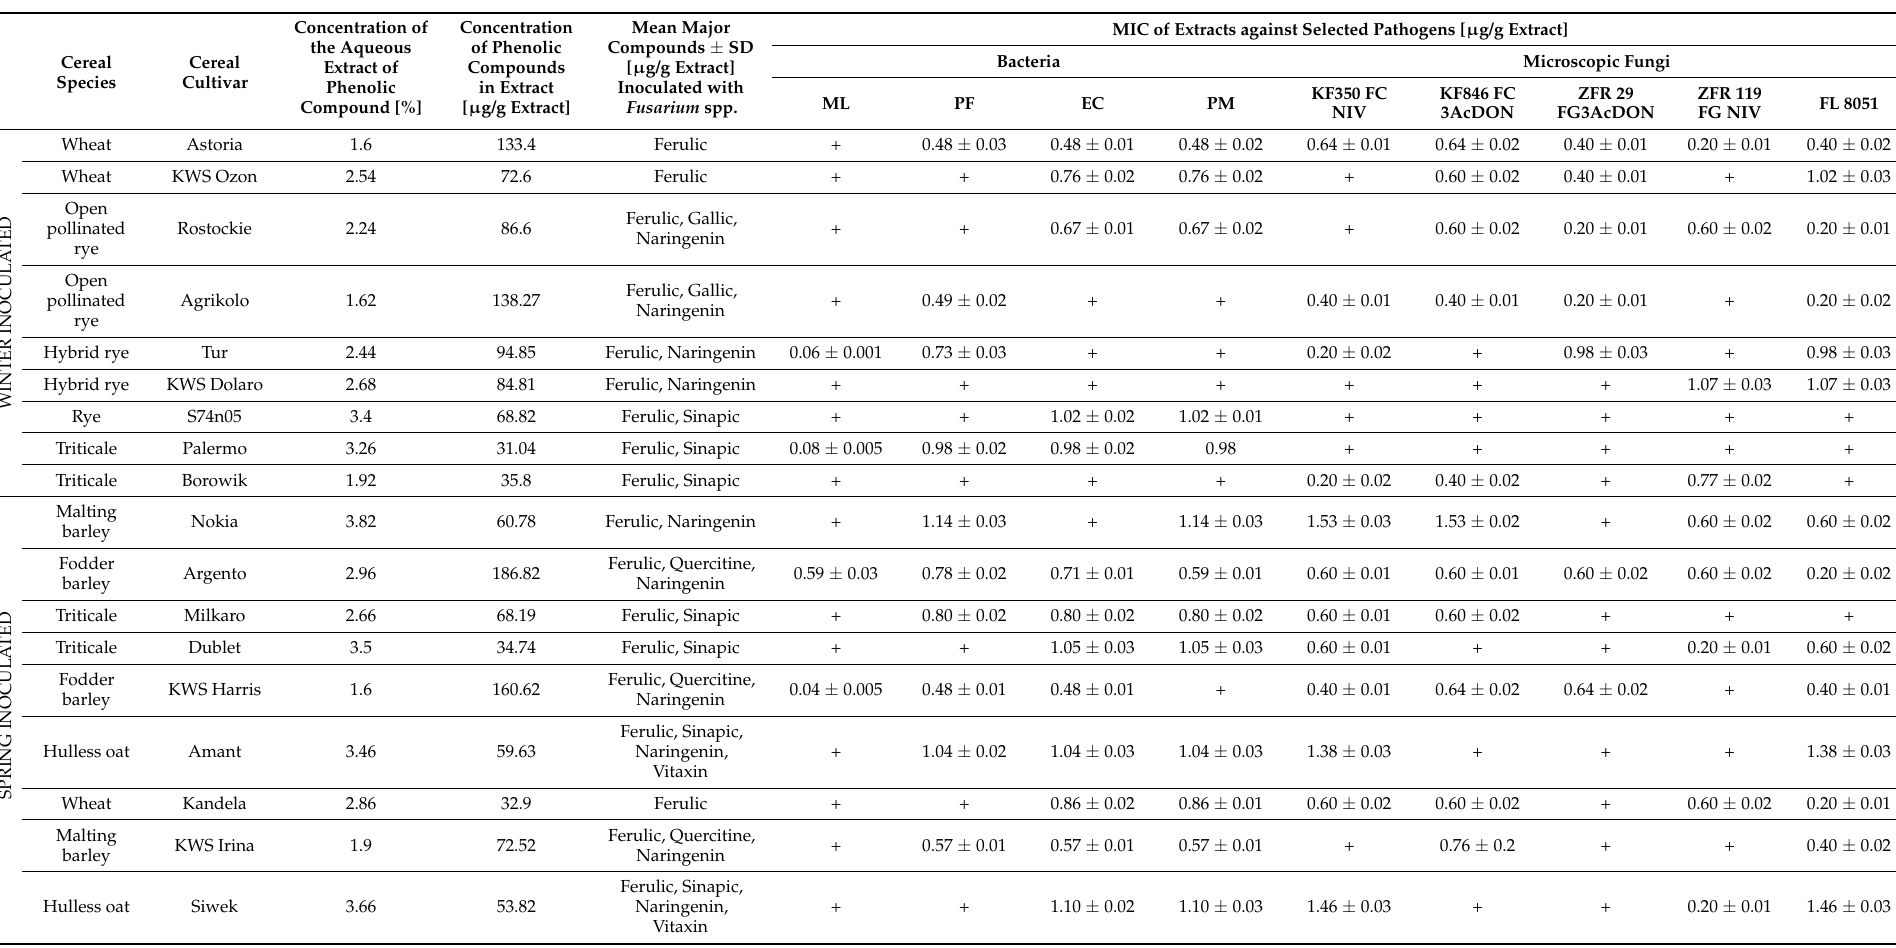
Table 4. Concentrations [%] of extracts of phenolic acids from selected genotypes of cereals grown in Poland and Minimum Inhibitory Concentration (MIC) of extracts against selected bacteria (ML, PF, EC, PM) and microscopic fungi ( Fusarium